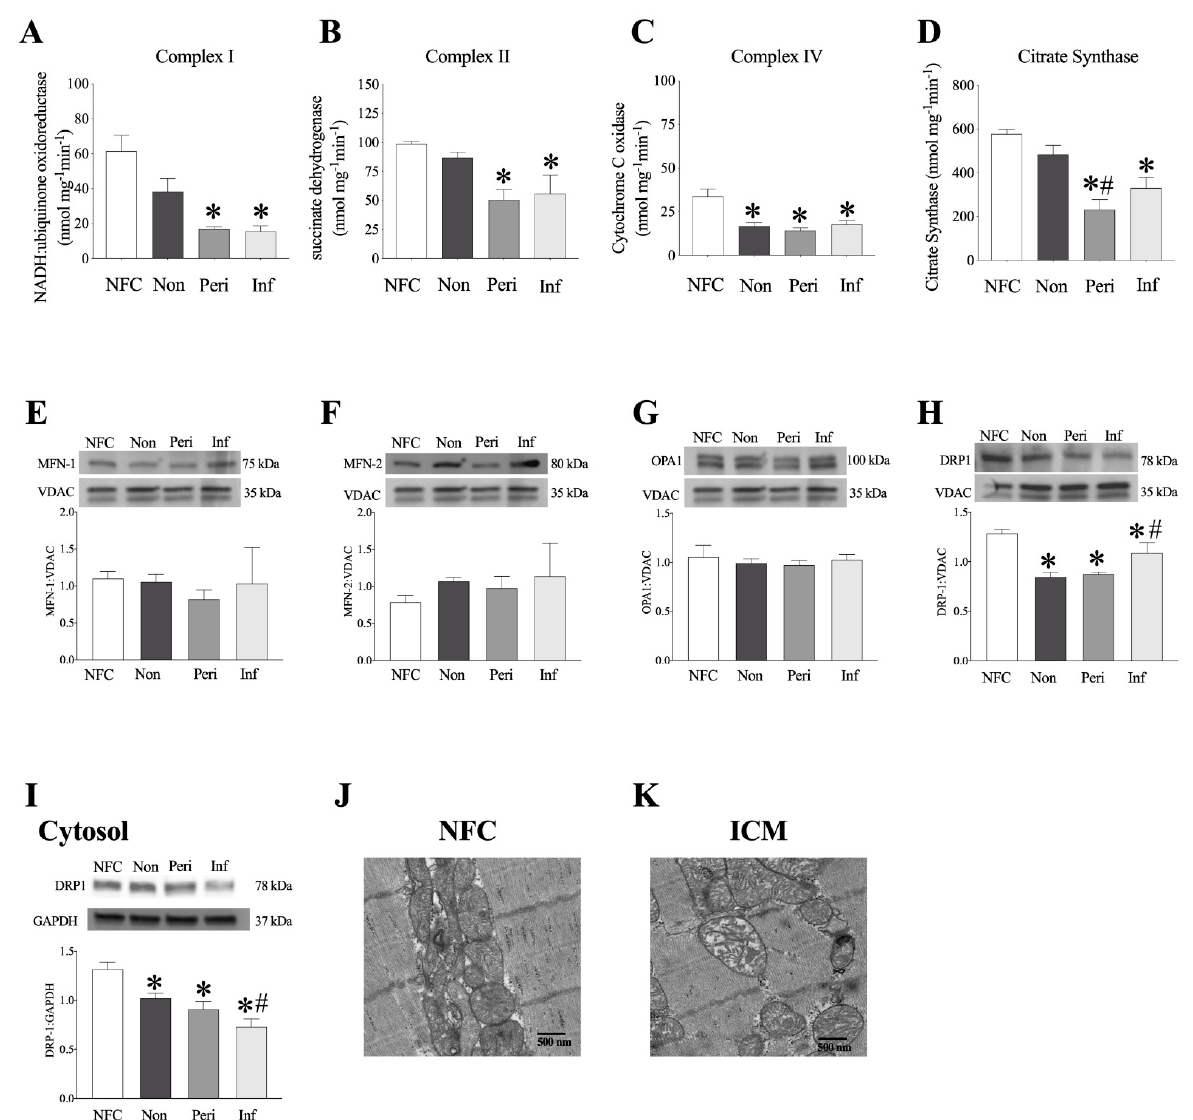
Figure 4. Electron transport chain activity and mitochondrial protein expression in female human hearts. ( A – D ) electron transport chain (ETC) complex activity (nmol mg − 1 min − 1 ) in non-failing control and MI female hearts. ( A ) Complex I (NADH:ubiquinone oxidoreductase) activity, ( B ) Complex II (succinate dehydrogenase, SDH), ( C ) Complex IV (cytochrome C oxidase, COX IV), and ( D ) citrate synthase (CS) activity. Mitochondrial ( E ) MFN-1, ( F ) MFN-2, ( G ) OPA1, ( H ) DRP-1 expression and representative blots normalized to VDAC. ( I ) Cytosolic DRP-1 normalized to GAPDH. Data are represented as mean ± SEM, n = 3–5. p ≤ 0.05; * vs. NFC, # vs. non-infarct. Representative transmission electron micrograph images taken from female NFC ( J ) and ICM ( K ) human hearts. Magnification set at 10,000×.